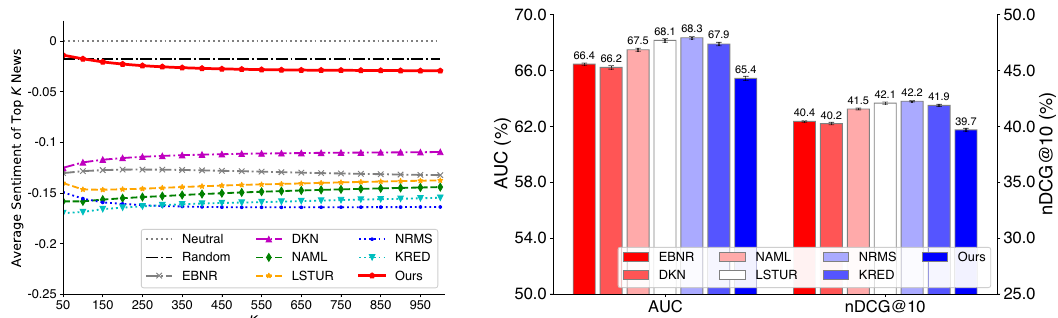
Fig. 4 The sentiment bias and recommendation performance of different methods. Left: the average sentiment scores of top K news recommended by different methods. The “ Random ” dashed line (black) represents recommending news randomly, and the expectation of its average sentiment is the average sentiment of the full news set. We use this score as an unbiased benchmark, and the distance to it is regarded as sentiment bias. The average sentiments of all compared SOTA deep learning-based news recommendation methods: EBNR (Okura et al., 2017), DKN (Wang et al. (2018), NAML (Wu et al., 2019a), LSTUR (An et al., 2019), NRMS (Wu et al., 2019c), and KRED (Liu et al., 2020) are much more negative than the unbiased benchmark, which indicates their sentiment manipulation phenomenon. The average sentiment of news recommended by our approach (red line) is very close to the benchmark, especially for the top 50 news articles that are preferentially displayed to users. It shows that our approach effectively mitigates AI models ’ sentiment manipulation. Right: the recommendation accuracy is evaluated by the AUC and nDCG@10 scores of news ranking. The results show that our approach achieves comparable results with other SOTA methods (the maximal performance drop is 2.9% AUC and 2.5% nDCG@10). The error bars represent mean scores with 0.95 con fi dence intervals ( n = 5 independent